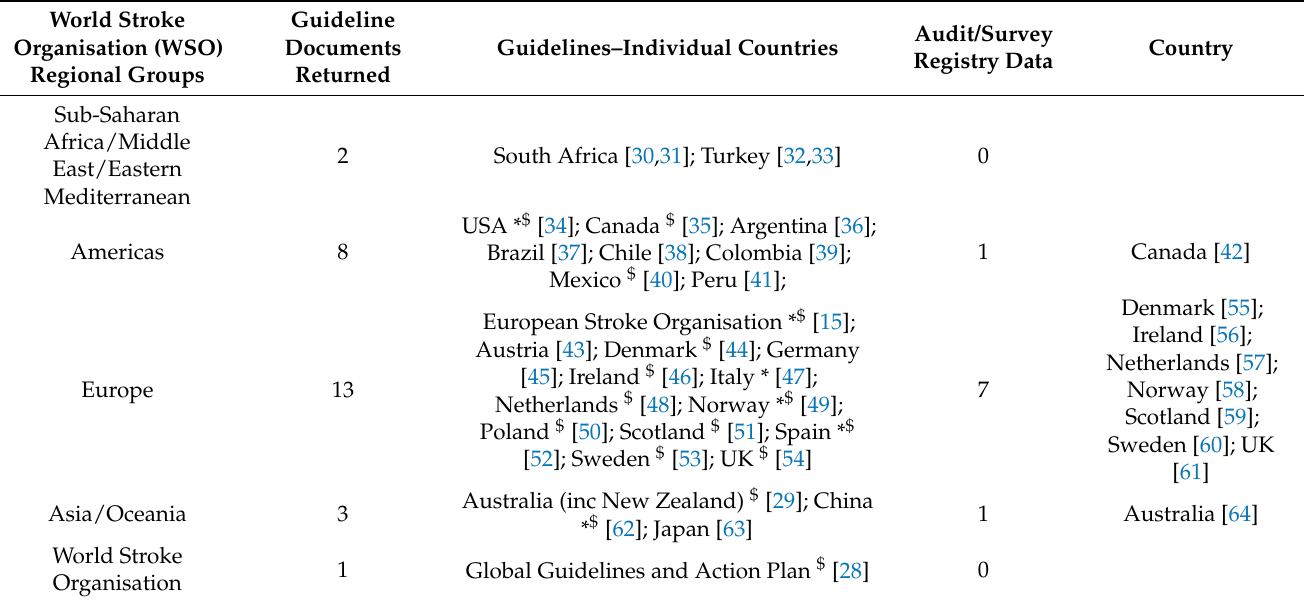
Table 2. Stroke Guideline Documents and Audits included in the Review by WSO Regional